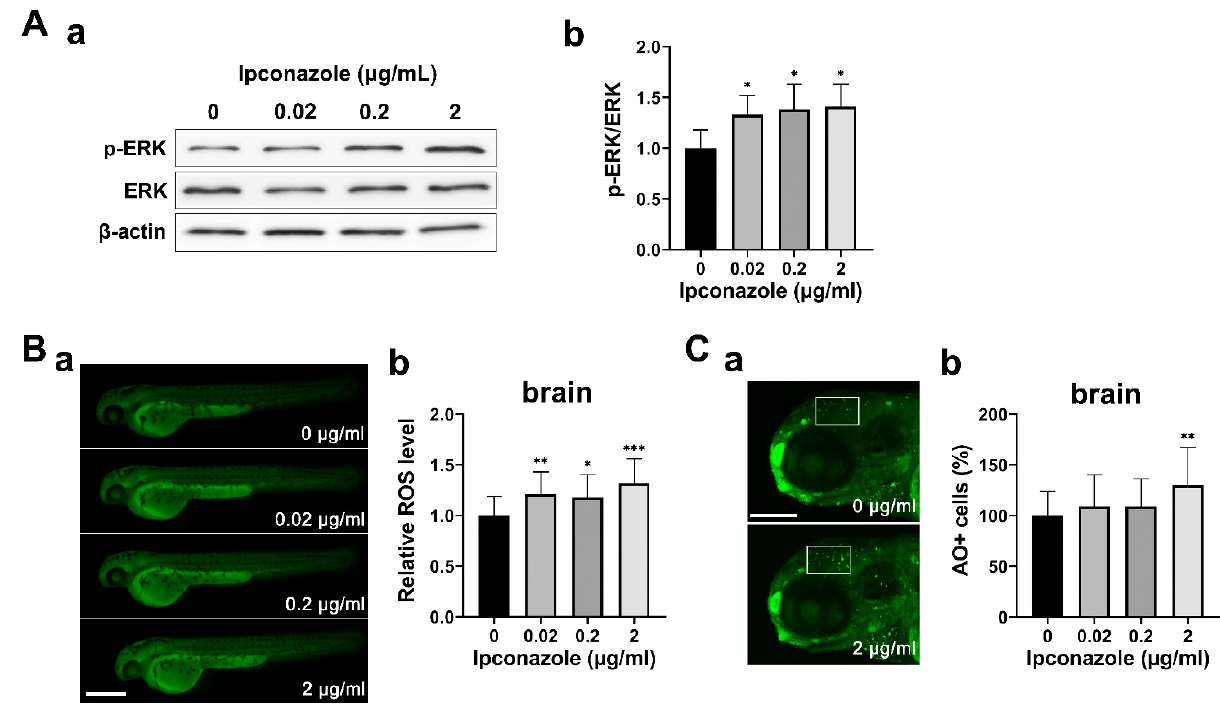
Figure 4. Ipconazole activates ERK1/2 signaling under oxidative stress. ( A ) Phosphorylation of ERK1/2 was increased in 28-hpf embryos treated with ipconazole. ( a ) Western blots using the antibodies against p-ERK, ERK, and β -actin proteins, respectively. ( b ) Graph of the quantitative analysis; ( B ) reactive oxygen species (ROS) were generated in the 48-hpf embryos treated with ipconazole. Scale bar, 500 µ m. ( a ) Lateral views of the embryos subjected to DCFH-DA (2 (cid:48) ,7 (cid:48) -dichlorodihydrofluorescein